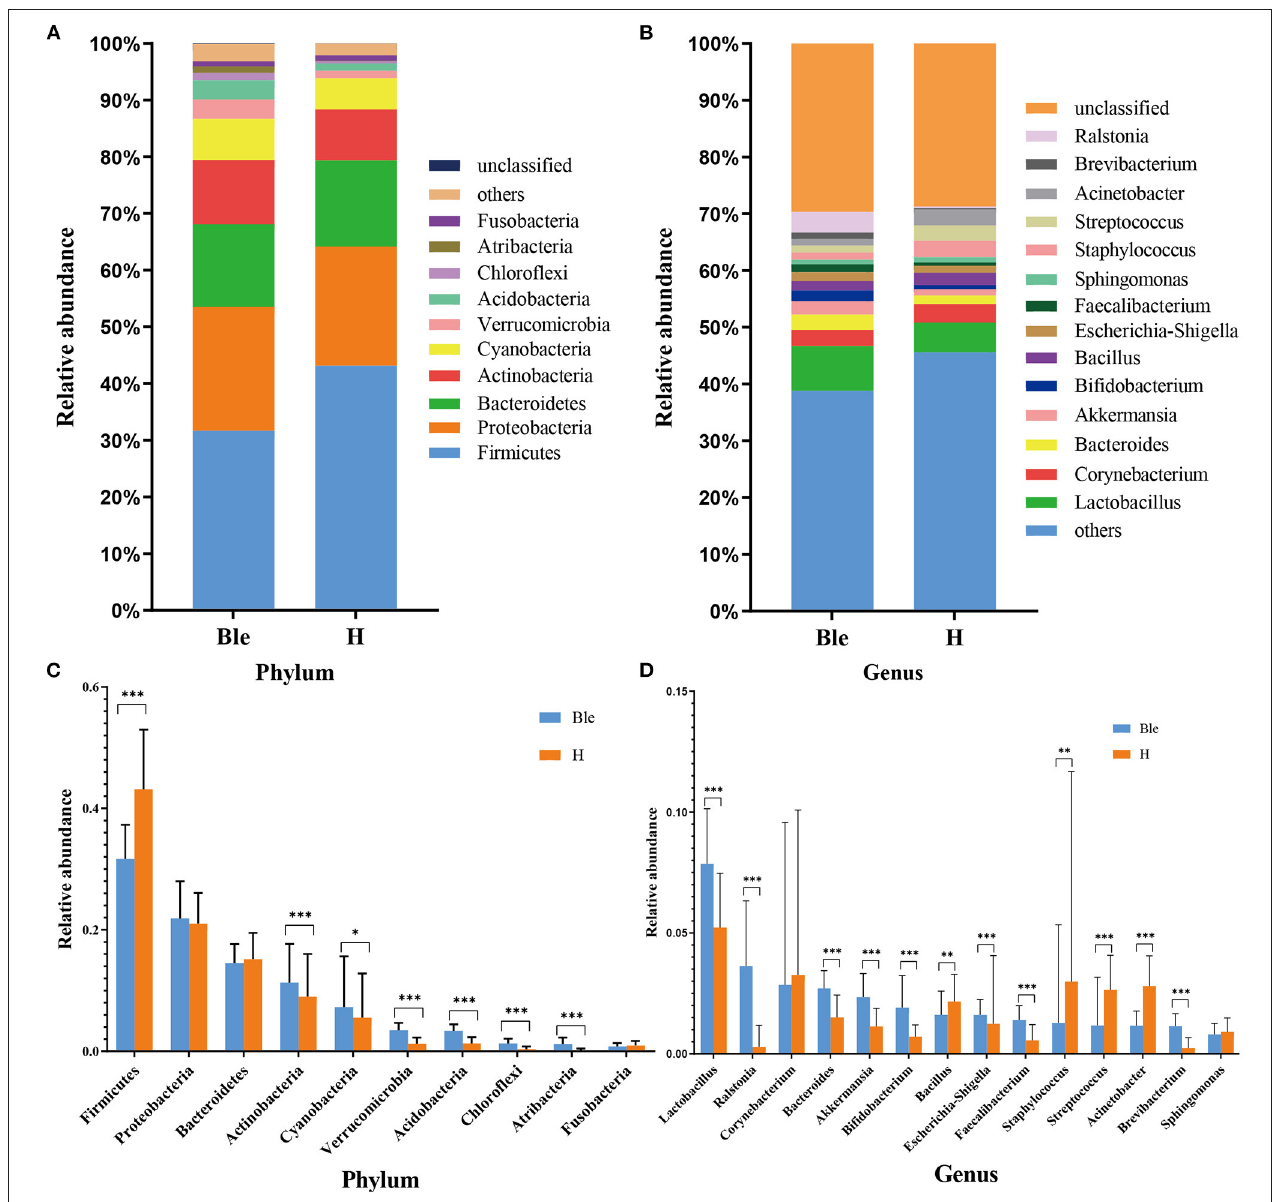
FIGURE 3 | Differences in microbiota composition between the blepharitis group and healthy control group. (A, B) Each phylotype (1% average relative abundance in groups) is indicated by a different color at the phylum and genus levels. (C, D) At the phylum or genus level, there was a significant difference in the abundance of ocular surface microbiota between the blepharitis group (Ble) and the healthy control group (H). * P < 0.05, ** P < 0.01, *** P < 0.001.